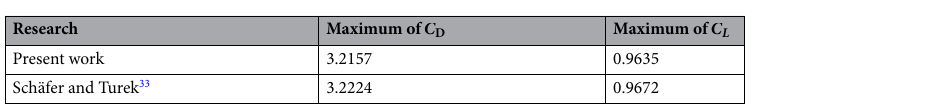
Table 1. Comparisons between the present results and the available in the literature for the problem with a bare cylinder.